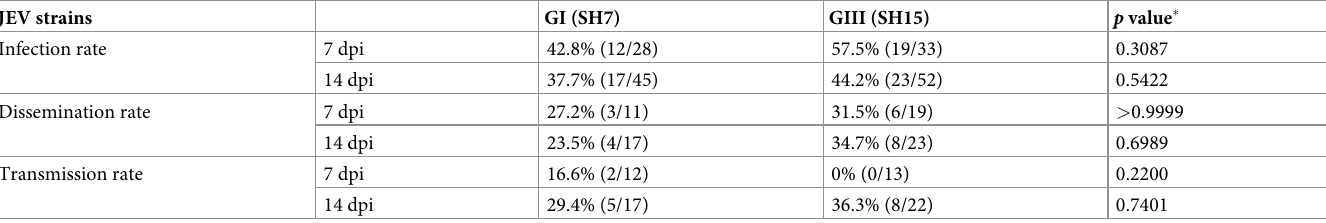
Table 2. Summary of the infection, dissemination and transmission rates of JEV infected mosquitoes. JEV strains